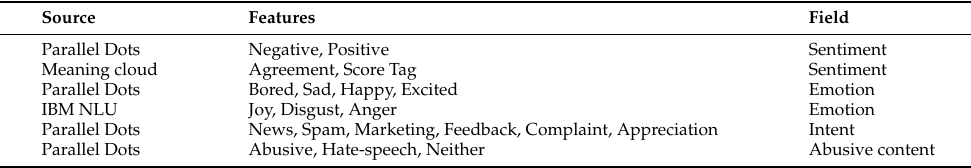
Table 3. Set of features extracted from different cloud